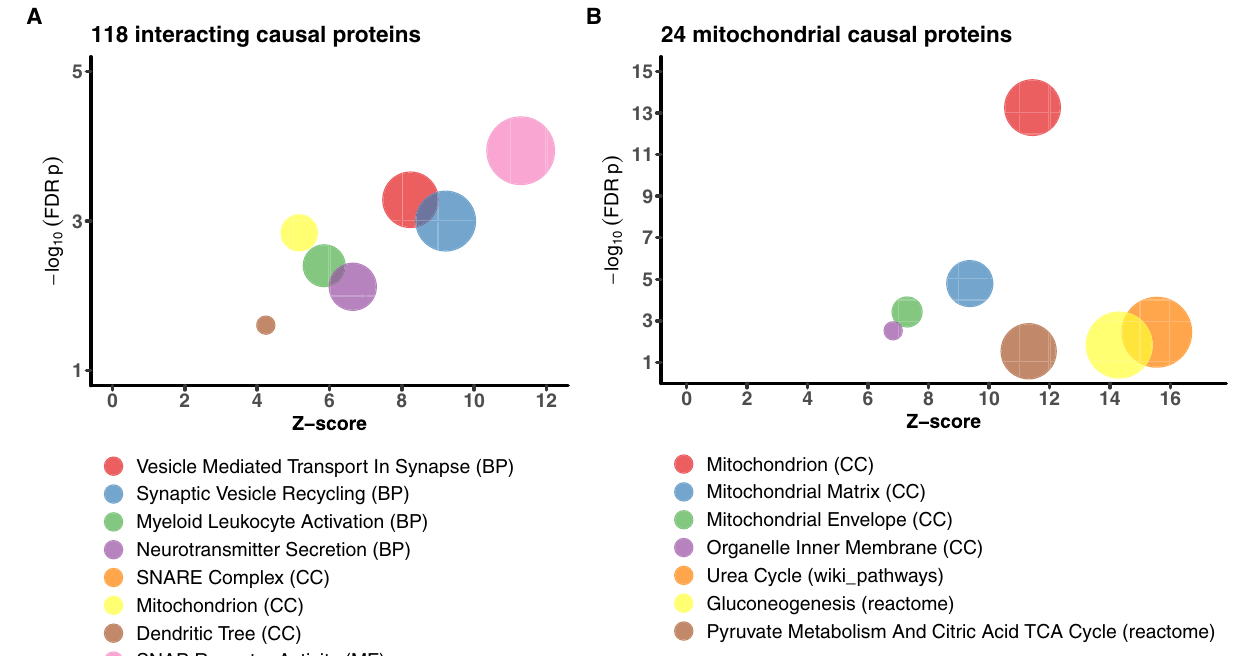
Fig. 7 | Gene set enrichment analysis (GSEA) for the 118 shared and interacting psychiatric and neurodegenerative causal proteins. A Biological processes that the 118 shared and interacting causal proteins were enriched in. The plot depicts